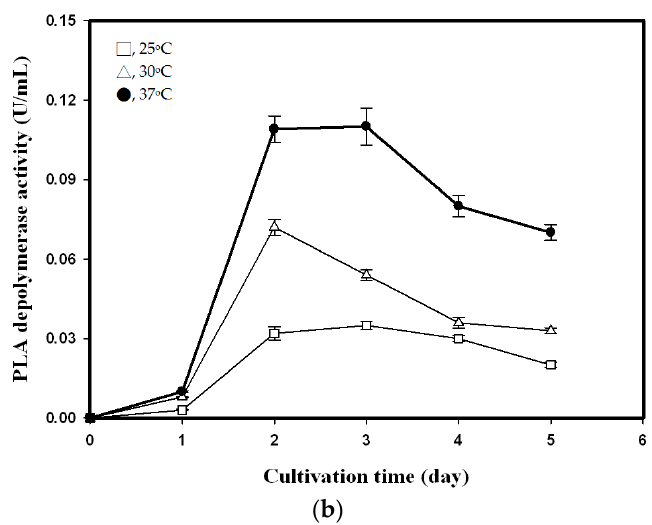
Figure 1. Effects of MPS concentration ( a ) and culture temperature ( b ) on cell growth (dashed line) and PLA depolymerase activity (solid line) of P. tamsuii TKU015. All data points are means ± S.D. (standard deviation) of three different experiments performed on different days (each experiment was conducted in triplicate).